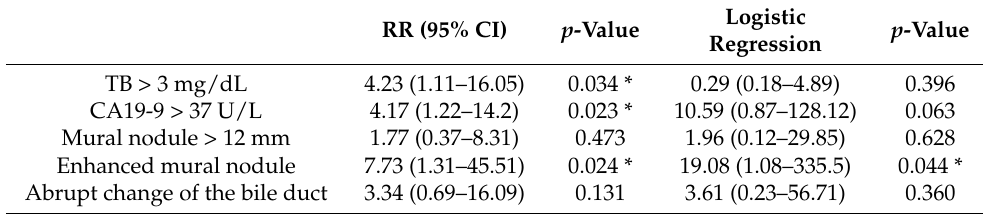
Table 3. Risk ratio and logistic regression analysis in extrahepatic IPNB.